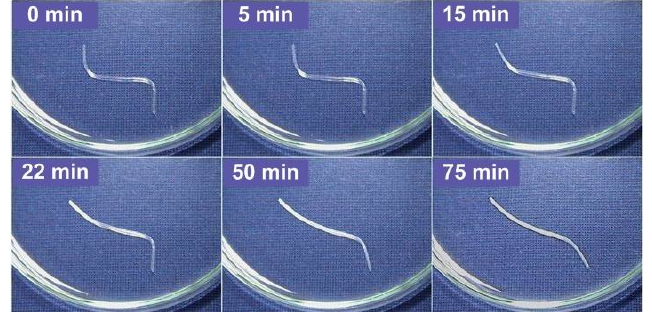
Figure 15. The triple-SME in a PU wire upon immersing into room temperature water. (Reproduced with permission from [101]. Copyright 2005 American Institute of